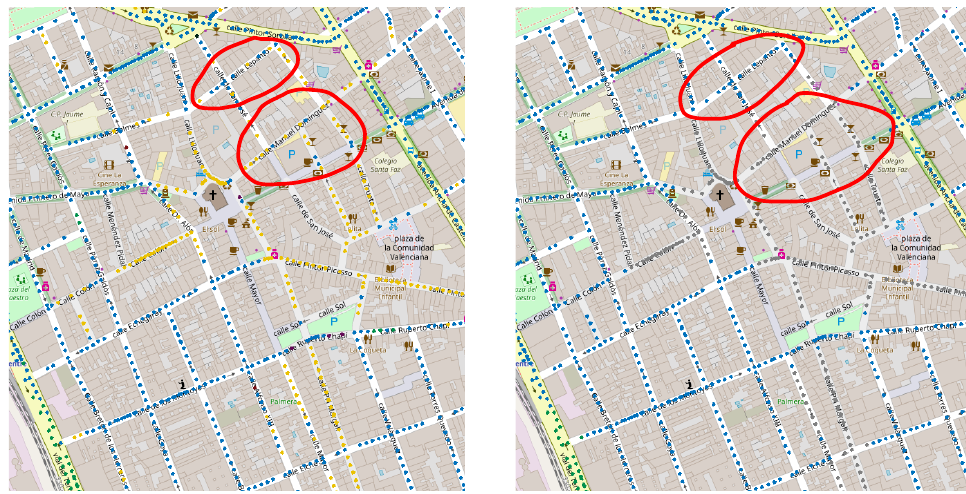
Figure 21. Comparison of smoothing results before ( left ) and after ( right ) applying KNN algorithm.